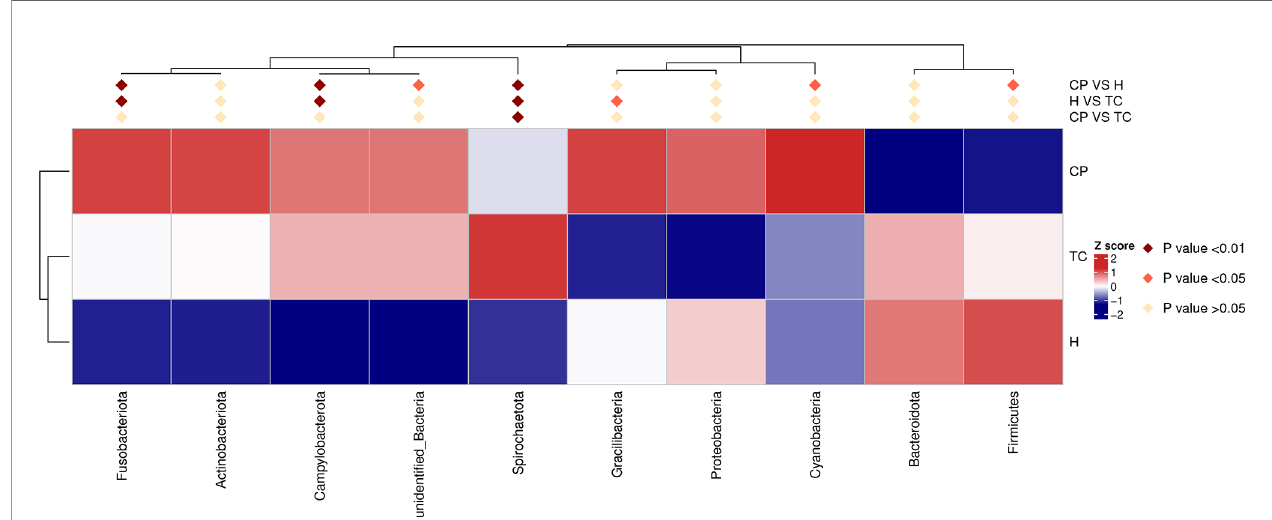
FIGURE 4 | MetaStat analysis; phylum annotation heatmap. Different colors in the heatmap represent the values obtained after the Z score of the relative content of differential metabolites is standardized, re fl ecting the level of their relative content (red represents high content, and blue represents low